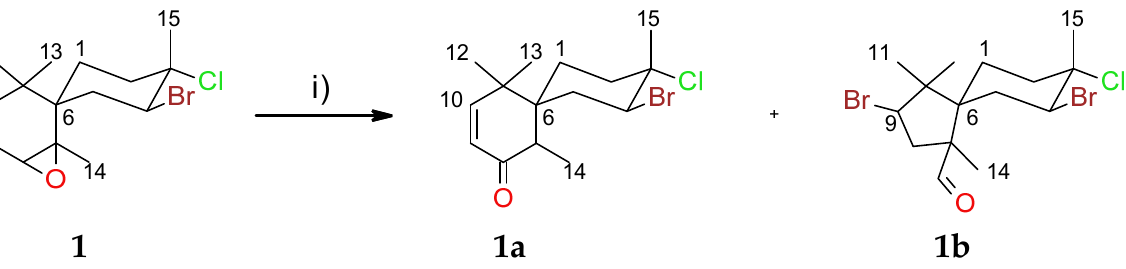
Scheme 1. Epoxy cleavage of compound 1 . Conditions: (i) BF 3 Et 2 O in anhydrous Et 2 O. Stirred for 18 h from − 78 °C to RT (room temperature). NMR data are available in the supplementary infor